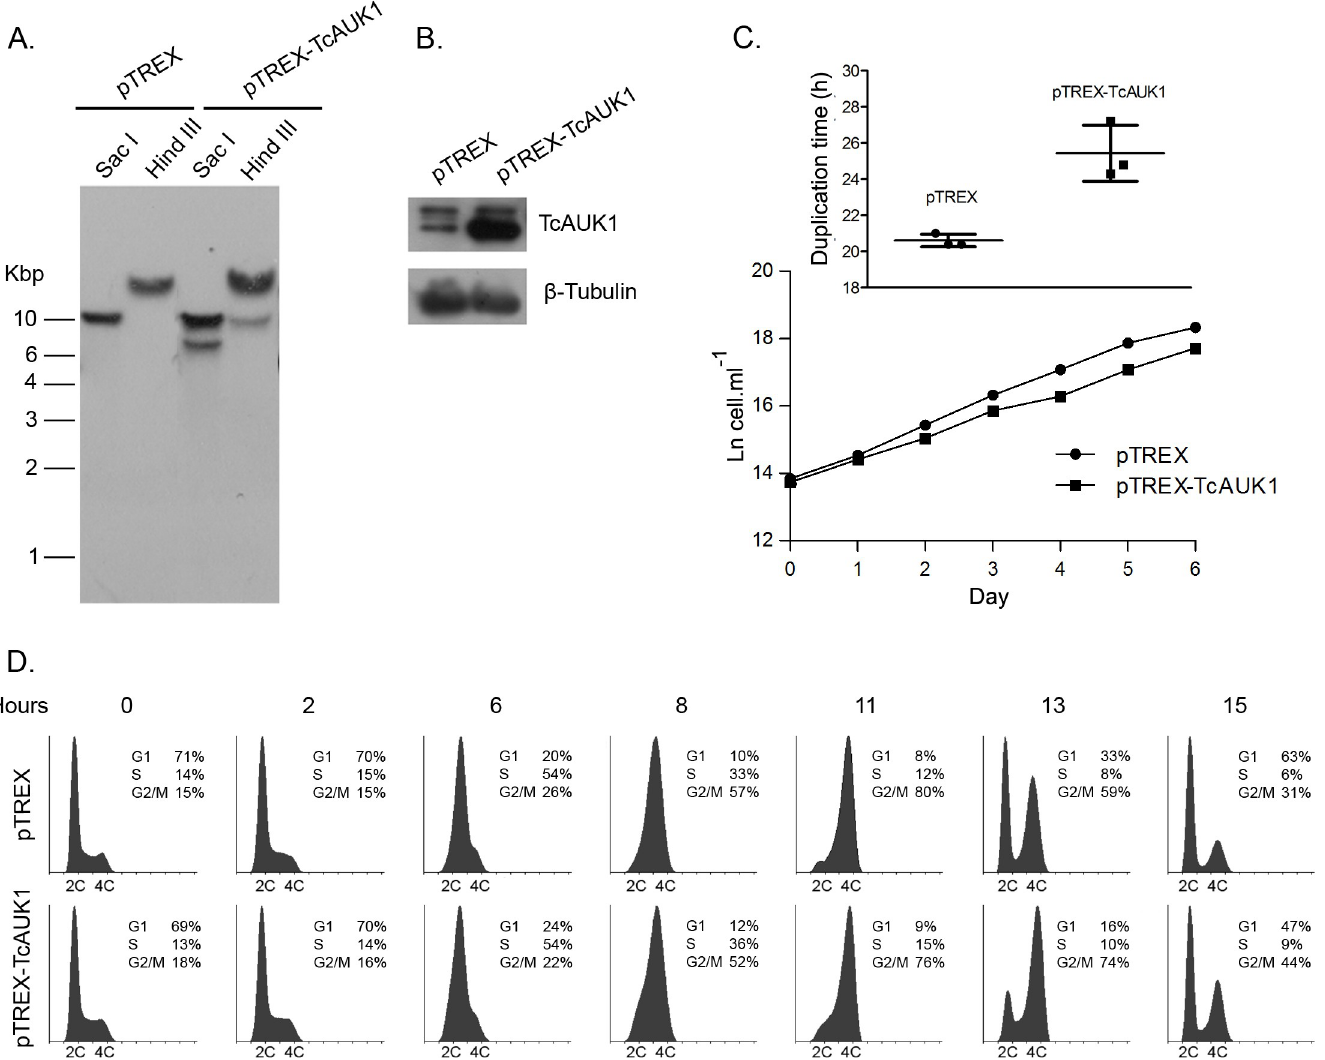
Fig 6. Analysis of TcAUK1 overexpressing epimastigotes. (A) Isolated DNA from pTREX and pTREX-TcAUK1 epimastigotes was treated with different restriction endonucleases and analyzed by Southern blot to confirm the extra copy of TcAUK1 in the genome of transgenic cells. (B) Immunoblot against TcAUK1 protein in pTREX and pTREX-TcAUK1 cells extracts. The β -Tubulin protein was used as loading control. (C) pTREX and clonal pTREX-TcAUK1 epimastigotes were cultivated and monitored for cell growth every day. Cell number was plotted in a logarithmic scale and the presented data is a mean ± s.d. of three independent cell cultures. Cells duplication time in each independent culture was calculated and a Paired T test (p < 0,05) was performed to compare between pTREX and pTREX-TcAUK1 epimastigotes (inset). (D) Flow cytometry analysis of DNA content in pTREX and pTREX-TcAUK1 epimastigotes. Cells were synchronized at G1-S transition and cell cycle progression was monitored up to 15 hs after